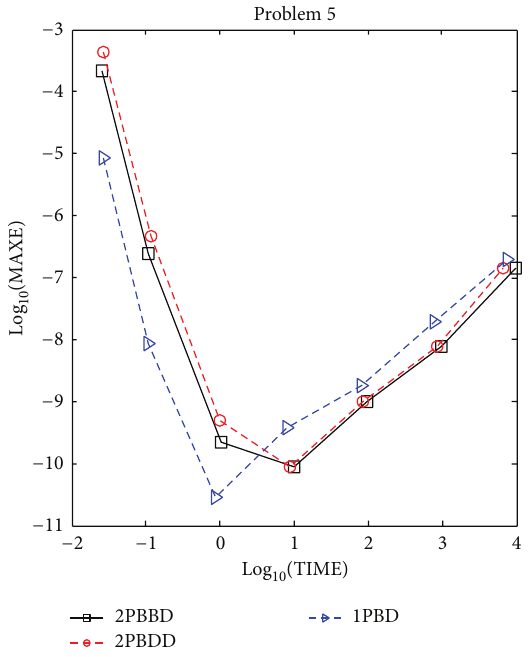
Figure 9: Graph of Log 10 ( MAXE ) plotted against Log 10 ( TIME ) for Problem 4.